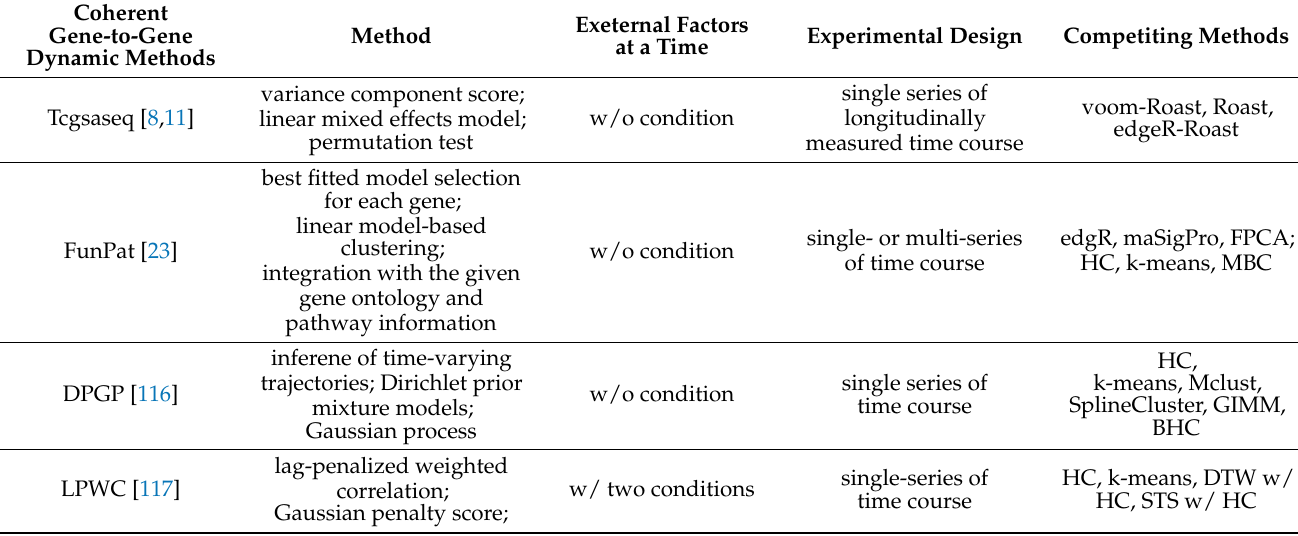
Table 4. Coherent gene-to-gene dynamic methods for non-periodical time course